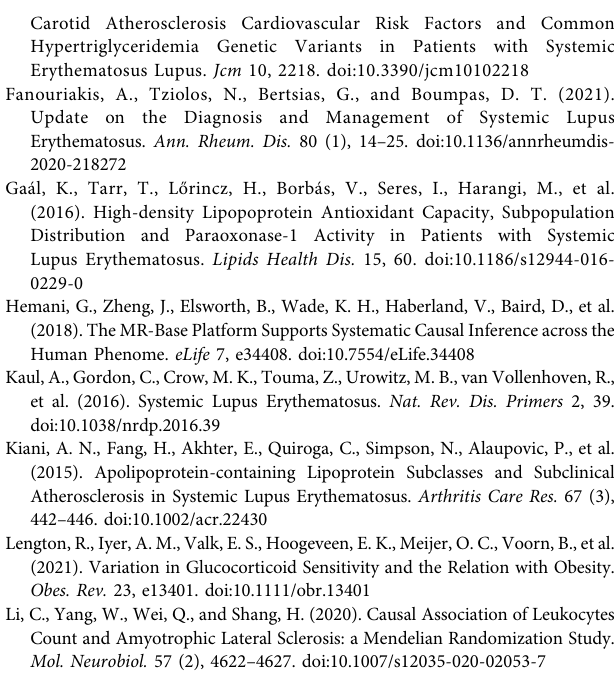
Supplementary Figure S1 | Forest plots of the causal effect of blood lipids on SLE risk. (A) HDL cholesterol. (B) LDL cholesterol. (C) TC. (D) TG. Supplementary Figure S2 | MR leave − one − out sensitivity analysis for blood lipids on SLE risk. (A) HDL cholesterol. (B) LDL cholesterol. (C) TC. (D) TG. Supplementary Figure S3 | Funnel plots of the causal effect of blood lipids on SLE risk. (A) HDL cholesterol. (B) LDL cholesterol. (C) TC. (D) TG. SupplementaryFigureS4| ScatterplotsofthecausaleffectofSLEonbloodsrisk. (A) HDL cholesterol. (B) LDL cholesterol. (C) TC. (D) TG. SupplementaryFigureS5| ForestplotsofthecausaleffectofSLElipidsonbloods risk. (A) HDL cholesterol. (B) LDL cholesterol. (C) TC. (D) TG. Supplementary Figure S6 | MR leave − one − out sensitivity analysis for SLE on blood lipids risk. (A) HDL cholesterol. (B) LDL cholesterol. (C) TC. (D) TG. Supplementary Figure S7 | Funnel plots of the causal effect of SLE on blood lipids risk. (A) HDL cholesterol. (B) LDL cholesterol. (C) TC. ( D) TG.